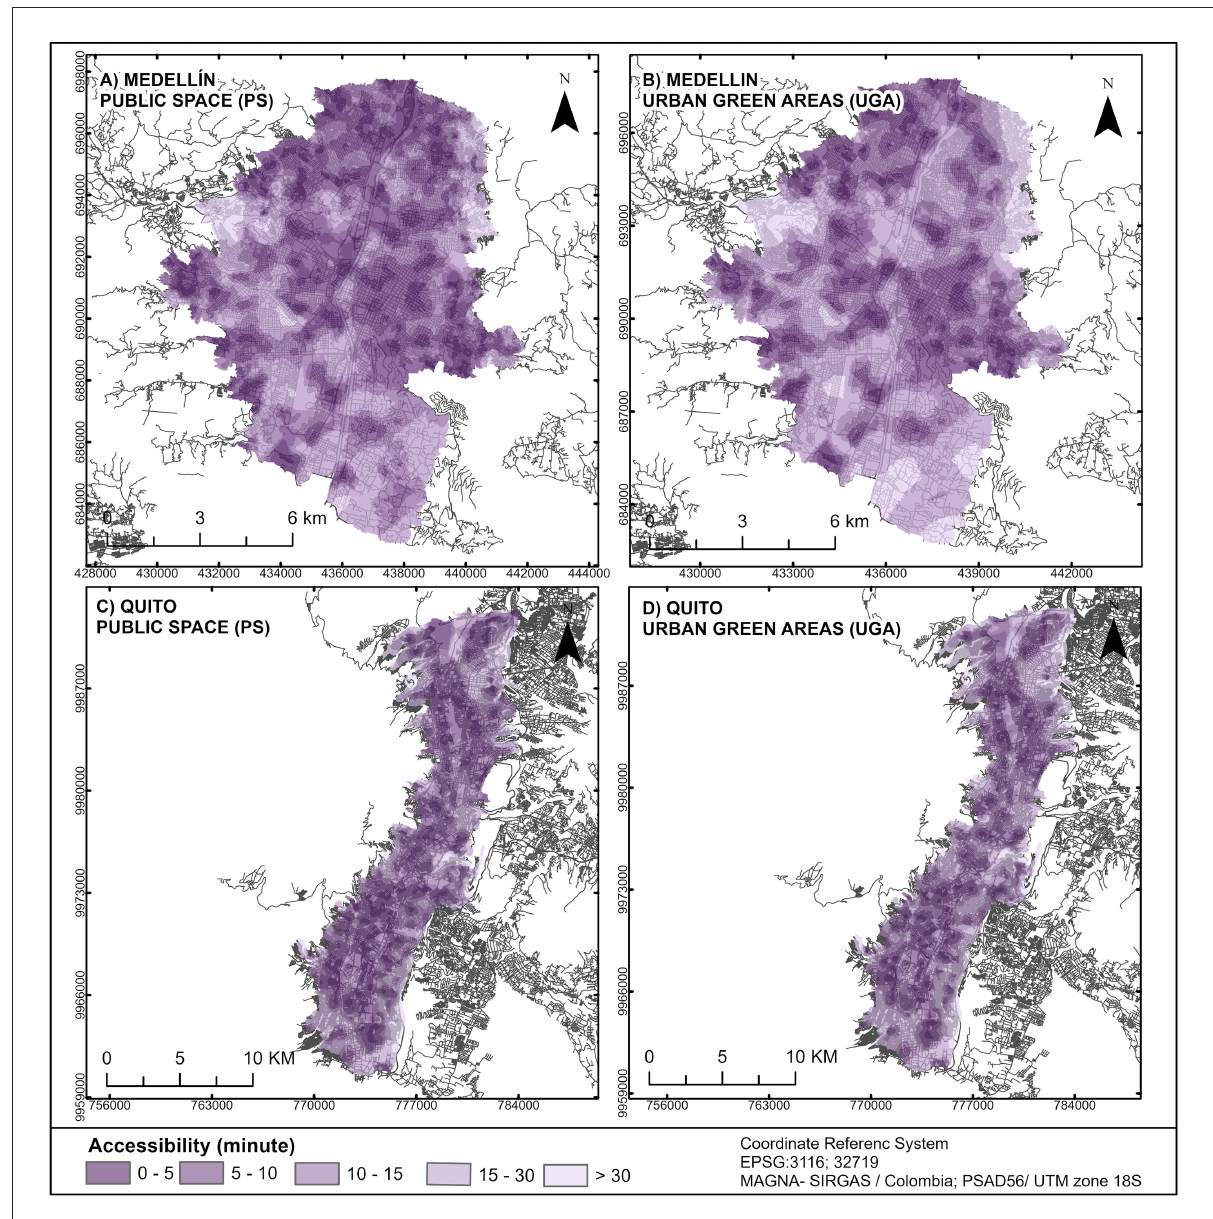
FIGURE6 Accessibility to public spaces (left) and to UGA (right) in walking distance [minutes]: Medellin (A,B) and Quito (C,D) , respectively. Source: Prepared by the